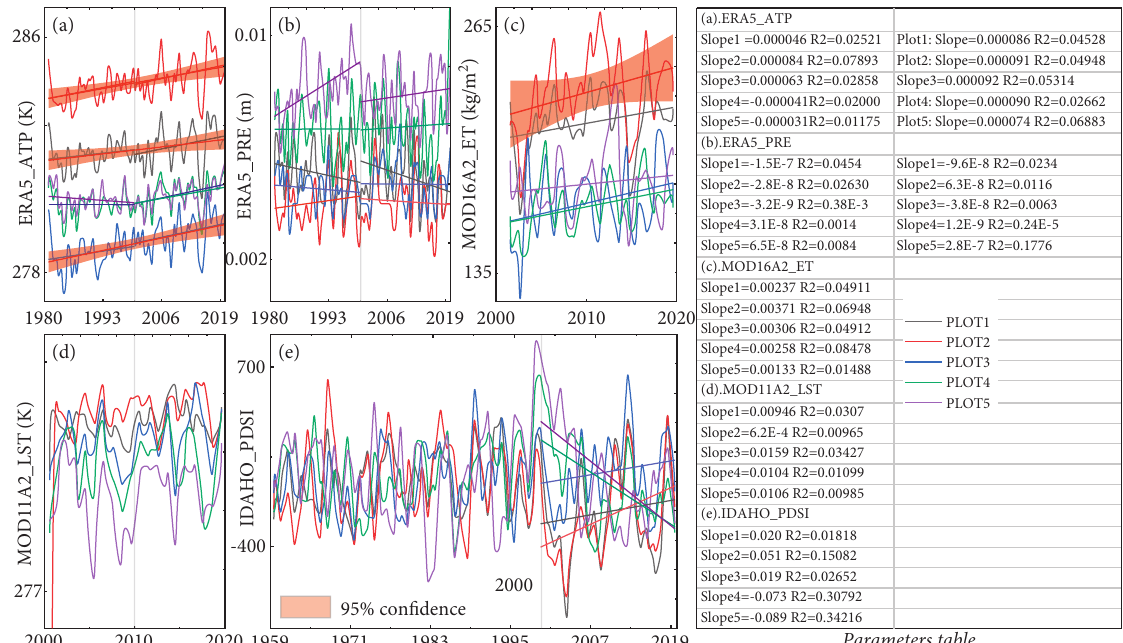
Figure 9: Climate change trend of the swamp wetland on a plot scale. (a), (b), (c), (d), and (e) is the change trend of ERA5 ATP (1980–2020), ERA5 PRE (1980–2020), MOD16A2 ET (2000–2020), MOD11A2 LST (2000–2020), and IDAHO PDSI (1959–2019), respectively.